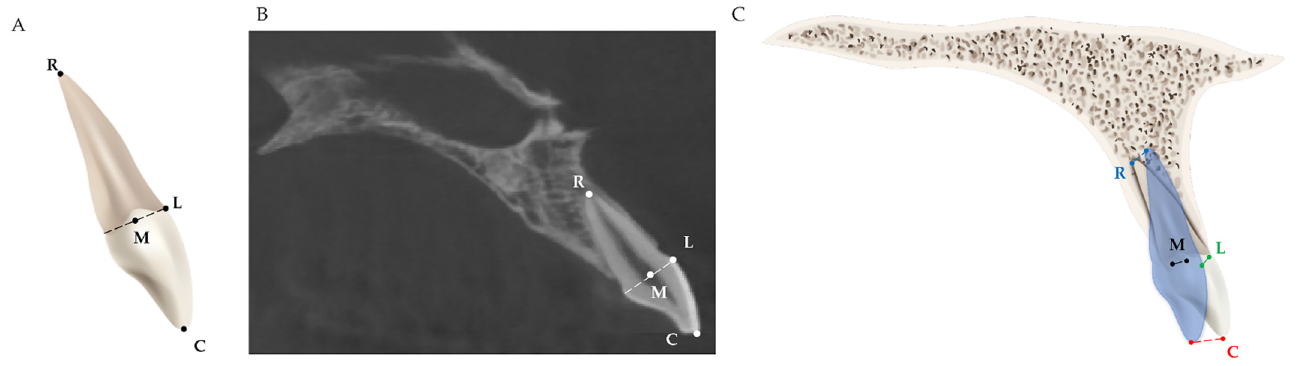
Figure 3. Schematic diagrams of the measurement of incisor movement: ( A ) four dental landmarks were used for measuring the incisor movement; ( B ) dental landmarks located on actual CBCT images; ( C ) the movement of these four landmarks. Red line: the movement of Point C; blue line: the movement of Point R; green line: the movement of Point L; black line: the movement of Point M.